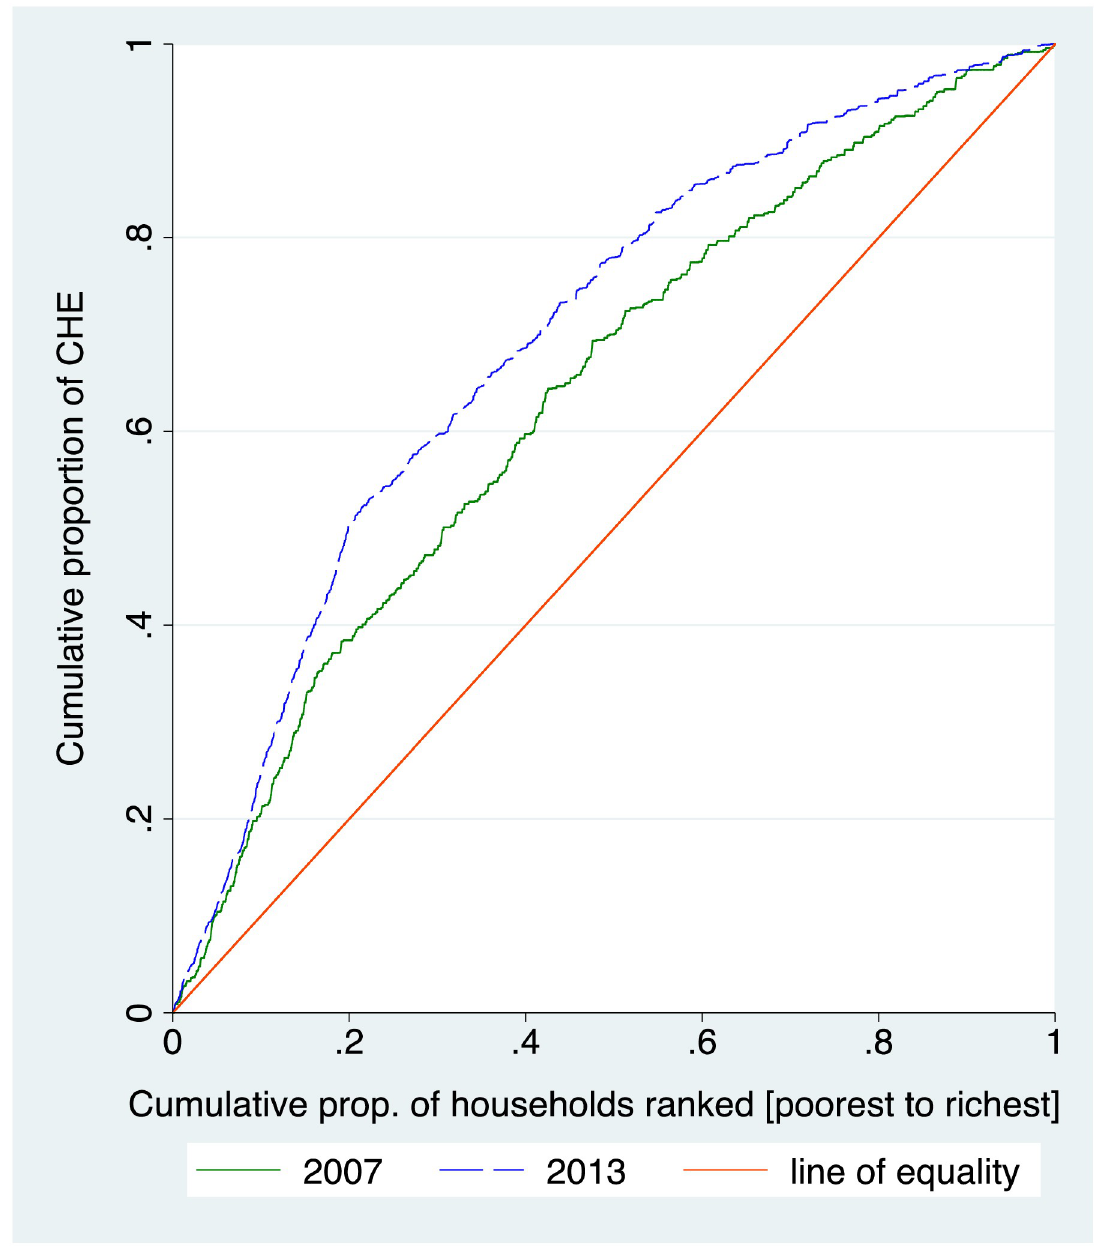
Fig 2. Concentration curves for catastrophic health expenditure, 2007 and